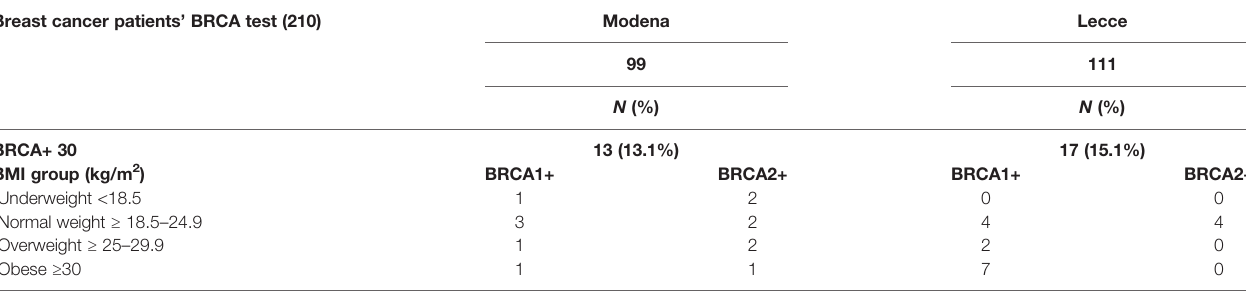
BMI, body mass index.